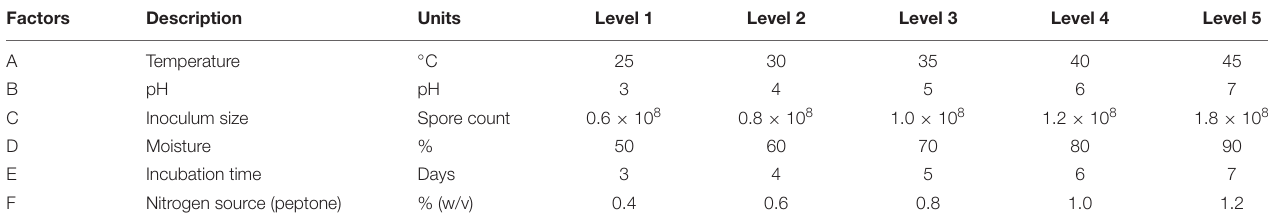
TABLE 2 | Factors with assigned levels of experimental design for xylanase production.